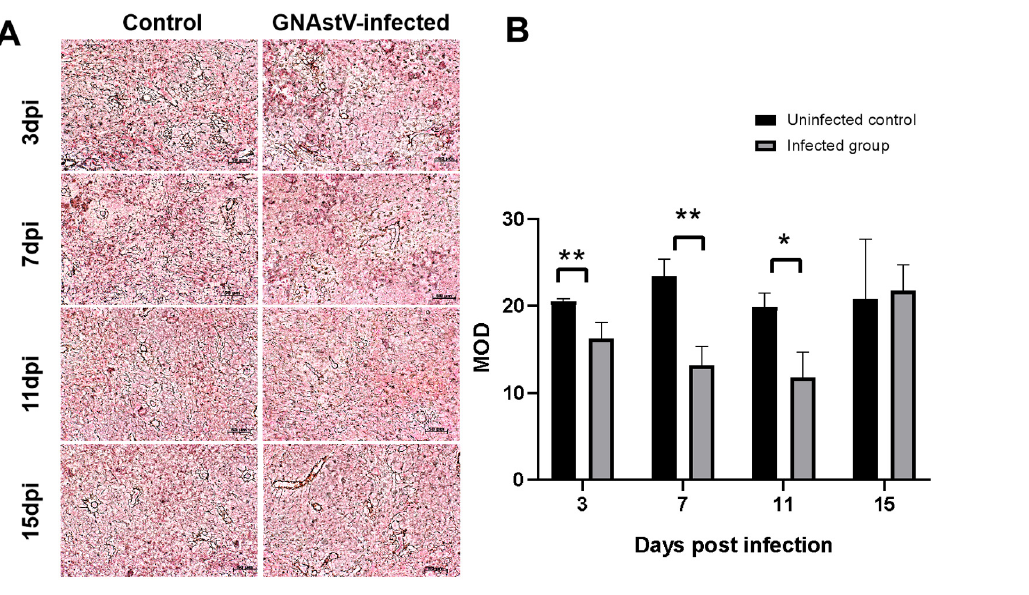
Figure 4. Changes in fibers associated with GNAstV infection. Spleen tissue was stained with the Gordon and Sweet method. The reticular fibers are indicated by black signals ( A ). The mean optical density (MOD) of reticular fibers was calculated by Image-Pro Plus ( B ). Scale bar: 50 µ m. Values are expressed as mean ± SD, n = 5. * p < 0.05; ** p <